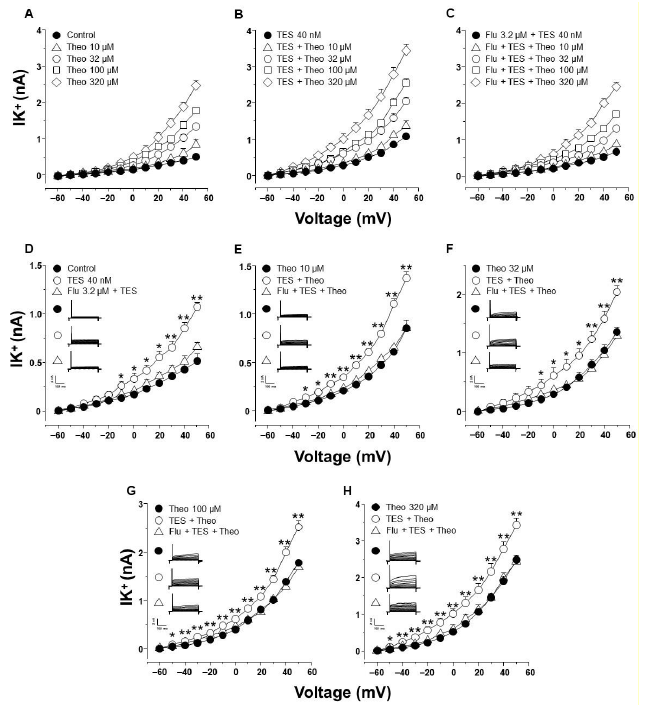
Figure 4. Chronic exposure to testosterone enhances theophylline-induced K + outward currents (IK + ) via the androgen receptor signaling pathway in cultured tracheal smooth muscle cells. All panels show typical current-voltage curves recorded in single cells. Airway myocytes were subjected to a step depolarization protocol from − 60 to +50 mV in 10 mV increments from a holding potential of − 60 mV for 500 ms. These stimulations evoked reproducible voltage-dependent K + currents (IK + ). ( A ) The application of increasing concentrations of theophylline (Theo) to single myocytes elicited a concentration-dependent increase in IK + ( n = 9). ( B ) Chronic pre-treatment with testosterone (TES, 40 nM for 48 h) enhanced theophylline-induced IK + ( n = 8). ( C ) The TES-induced increase in IK + was reversed by the androgen receptor antagonist, flutamide (Flu) 3.2 µ M ( n = 7). For illustration, panels ( D – H ) summarize the statistical analysis for each concentration of theophylline tested, including experiments with TES alone and flutamide. Note that Flu in these panels abolishes the effect of TES on the theophylline-elicited increase in IK + . Note also in ( D ) that TES alone causes a significant improvement in IK + that is abolished by Flu. The insets depict original recordings. Observe that different Y -axis scales are used in some figures to make statistical significance clear. Symbols represent mean ± S.E.M. In panel ( D ), * p < 0.05, ** p < 0.01 when comparing TES (o) or Flu + TES ( (cid:3) ) groups vs. control group ( • ). In panels ( E – H ), * p < 0.05, ** p < 0.01 when comparing TES + Theo group (o) vs. Theo ( • ) or Flu + TES + Theo ( ∆ ) groups. A one-way analysis of variance was performed, followed by Dunnett’s